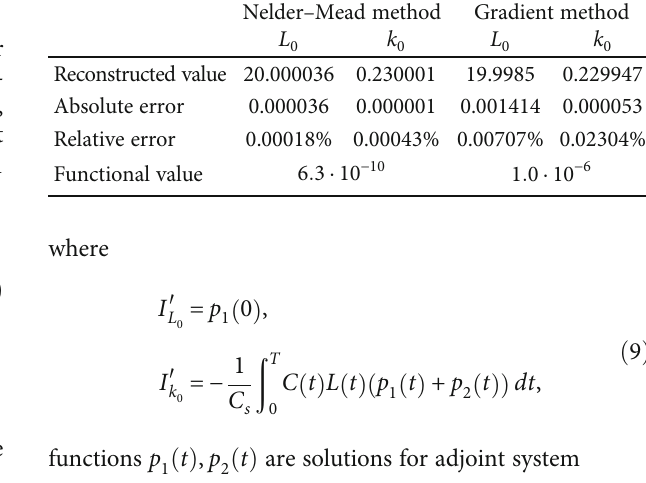
Table 1: Results of calculations with exact values of C